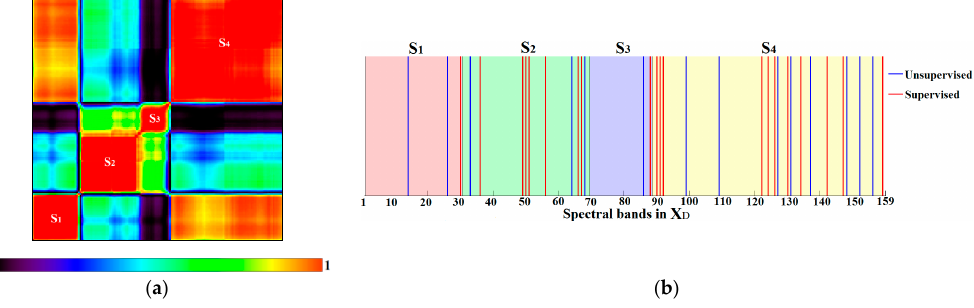
Figure 7. ( a ) The R 2 correction matrix of X D image, where four highly correlated adjacent band groups are highlighted as S 1 –S 4 ; ( b ) the first 20 selected bands and their corresponding positions in each group (Umatilla County dataset). Table 3. Number of class training samples used in the supervised CD approaches (Umatilla county dataset).